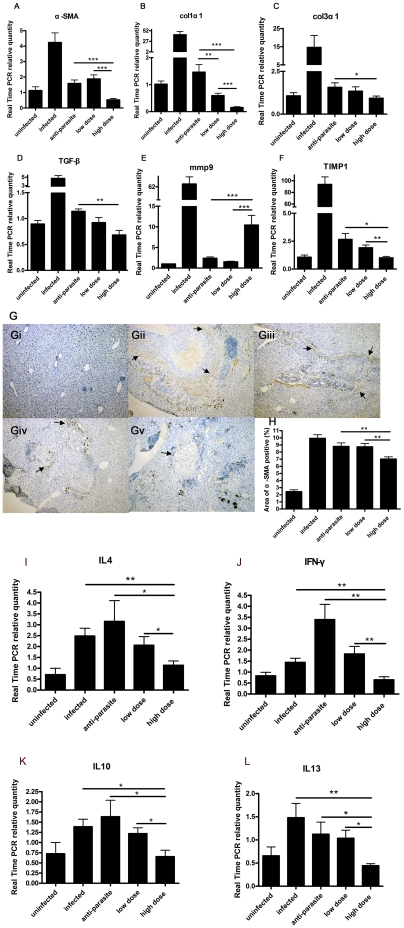
Anti-fibrosis treatment with prizaquantel inhibited expressions of profibrotic genes and α-SMA protein expression in liver, but increased MMP9 mRNA expressions of mice 15 weeks post infection with Schistosoma japonicum.(A)α-SMA; (B)Col1α1; (C)Col3α1; (D)TGF-β were reduced by anti-fibrosis treatment with high dose prizaquantel. (E)MMP9 levels in high dose group were increased about 10 fold compared with uninfected group, whereas (F) TIMP1 levels were decreased nearly to uninfected level. α-SMA protein expressions was assessed by immunohistochemistry. (G) Representative images of immunohistochemistry by light microscope (×100). Gi, uninfected; Gii, infected; Giii, anti-parasite; Giv, low dose; Gv, high dose. Arrows showed the positive staining. (H) α-SMA positive areas were measured by software IPP6.0. Expression of IL-4 (I), IL-10 (J), IL-13(K) and IFN-γ (L) were significantly reduced in high dose group compared respectively with infected, anti-parasite or low dose group. (* p<0.05, ** p<0.01, *** p<0.001).